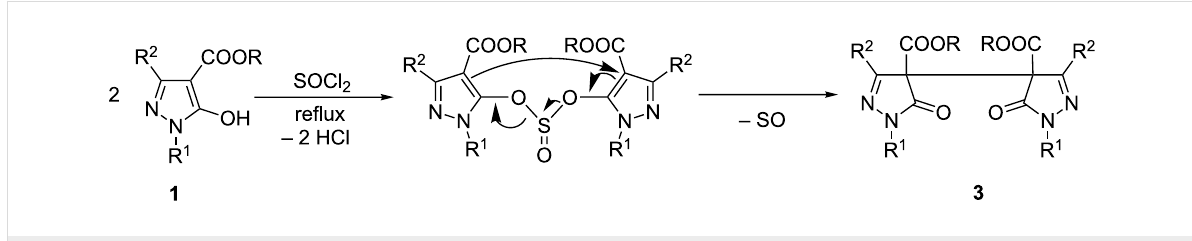
Scheme 6: Possible reaction mechanism for the transformation 1 → 3 .